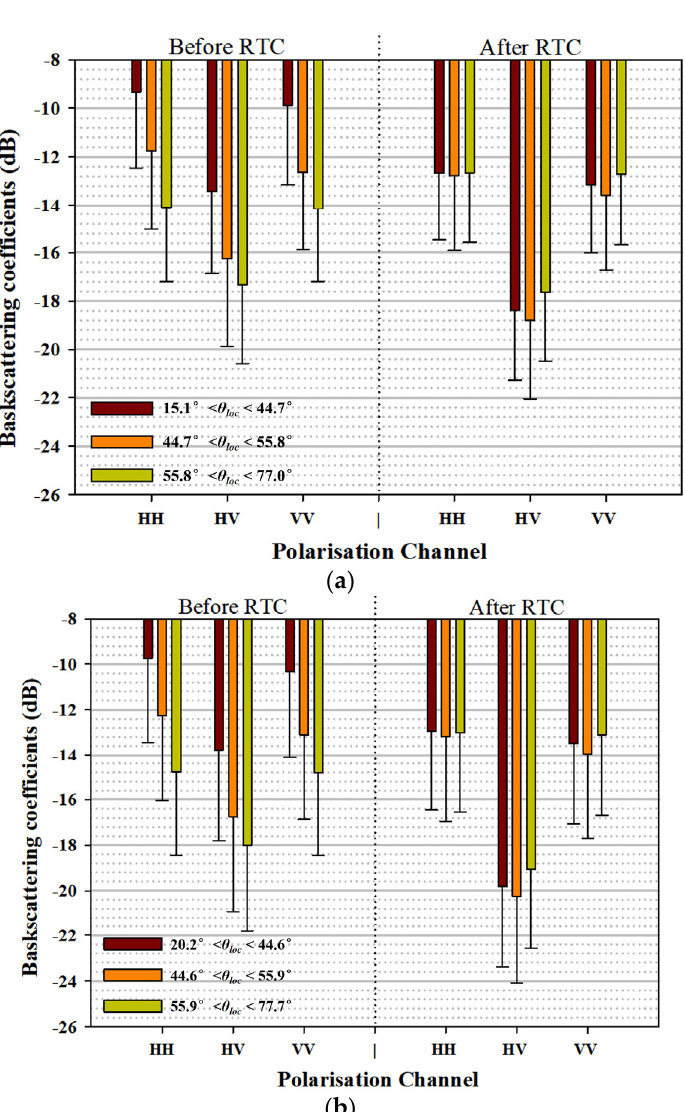
Figure 12. The statistical characteristics (mean and standard deviation) of backscattering coefficients at different incident angles (grouped by 33.3% and 66.6% quantiles) and different polarizations before and after RTC. ( a ) Based on RPC model; ( b ) Based on RD model using GAMMA software (version: